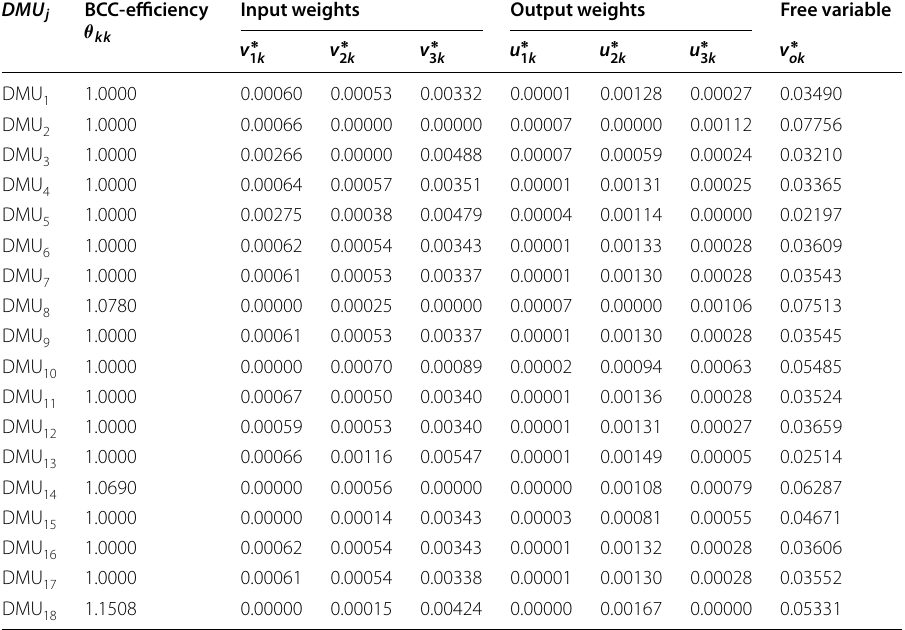
Table 8 Optimal input and output